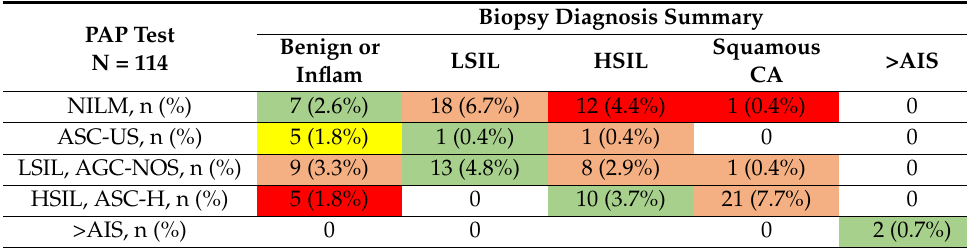
Green—agreement; yellow—minor variance; orange—minor (undercall/overcall) discrepancy; and red—major discrepancy (undercall/overcall) cases. Percentage calculated for all included cases. The CHC and error results obtained are presented in Figure 1. The majority of dis- crepancies were associated with PAP test sampling errors (16.8%), while the least common errors were interpretative errors (4.8%).